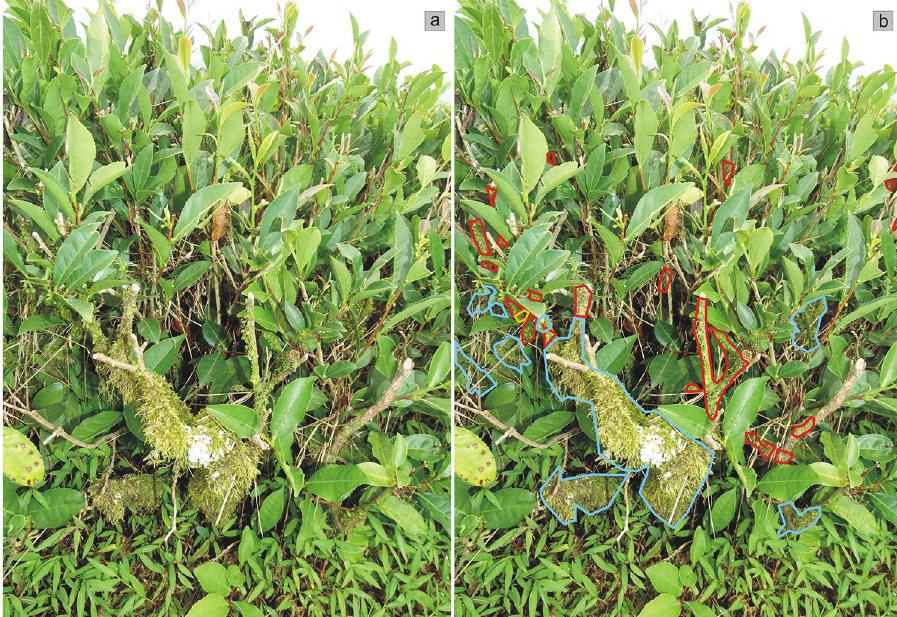
Figure 4. Example distribution patterns and coverage by selected taxa—Kobuleti plantation. ( a ) Output photo, ( b ) photo with mosses taxa marked (photo by R. Piwowarczyk, 29 July 2018). Explanation: Hypnum cupressiforme —blue, Orthotrichum sp. div.—orange, Radula complanata